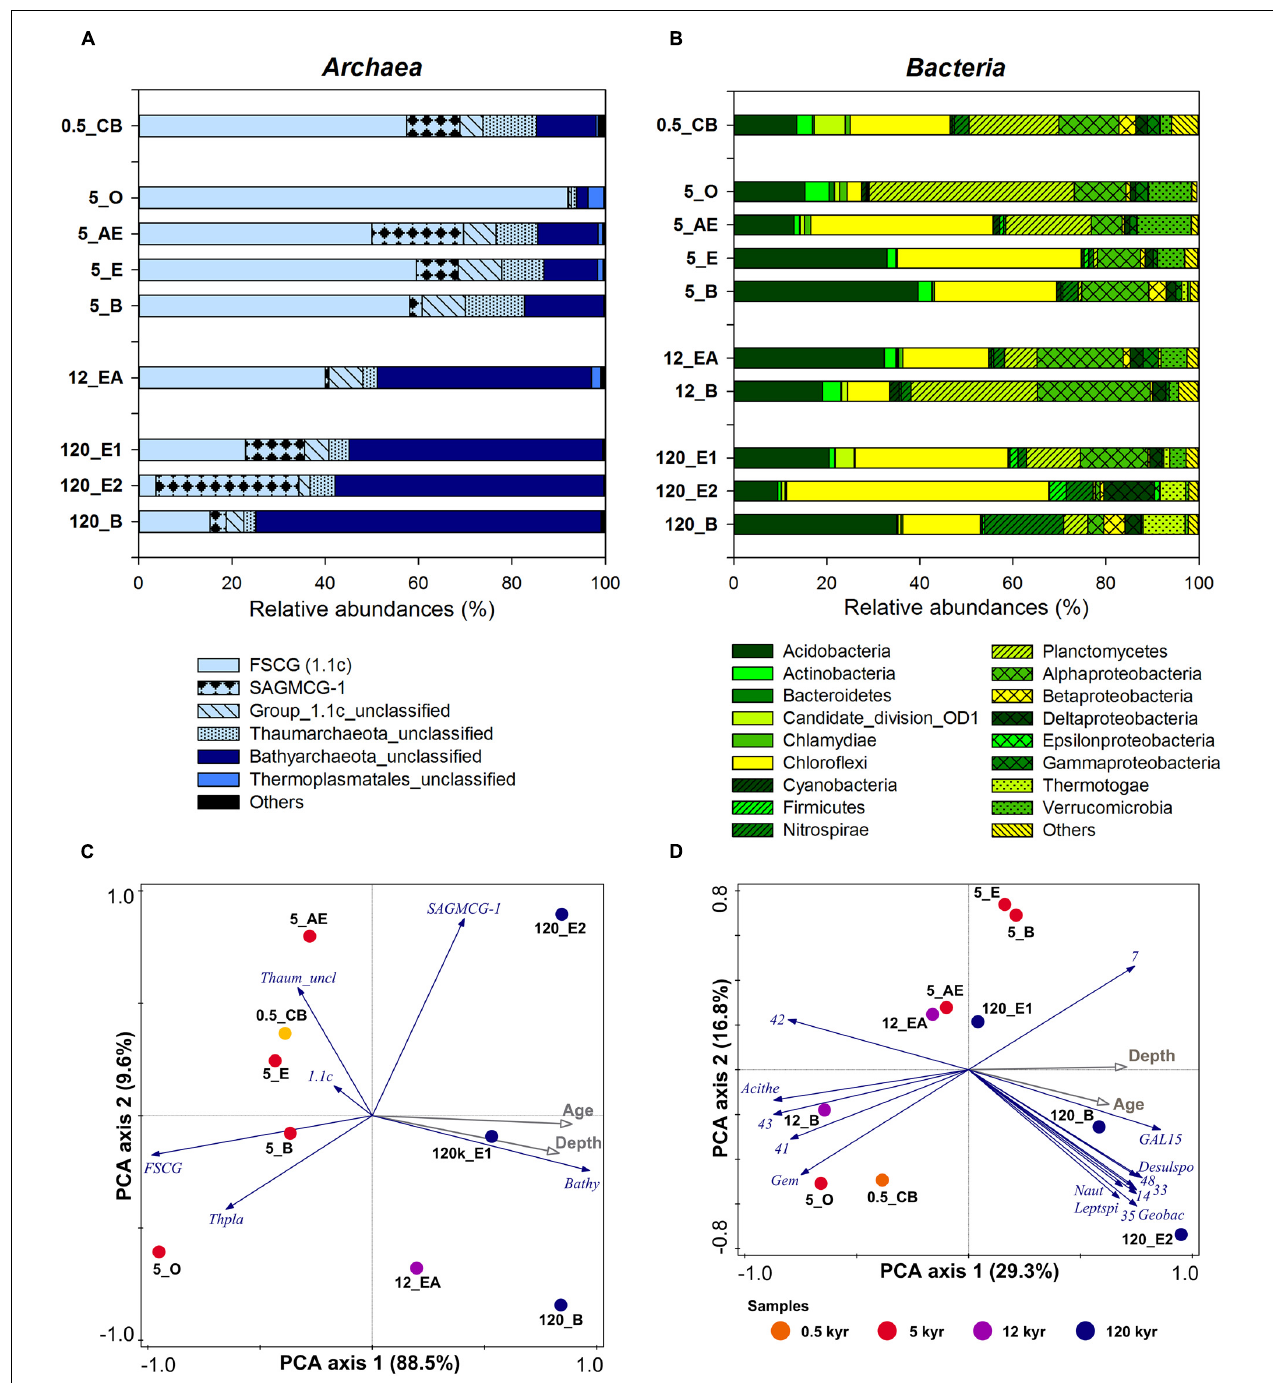
FIGURE 2 | Microbial community composition of selected original soil samples (0.5, 5, 12, and 120 kyr soil age) along the Franz Josef chronosequence based on pyrosequencing analysis. Relative abundances (%) of (A) archaeal groups, and (B) bacterial phyla and classes ( Proteobacteria ). (C) Principal component analysis (PCA) of archaeal community composition based on relative abundances of archaeal groups with soil age and soil depth as supplementary variables (gray arrows). 1.1c , Thaumarchaeota 1.1c ; Bathy , Bathyarchaeota ; FSCG , Forest Soil Crenarchaeotal Group; SAGMCG-1 , South African Gold Mine Crenarchaeotal Group 1 ; Thaum_uncl , unclassified Thaumarchaeota , and Thpla , Thermoplasmatales . (D) PCA of bacterial community composition based on log-transformed relative abundances of bacterial genera (15 best-fitting as blue arrows) with soil age and soil depth as supplementary variables (gray arrows). Acithe , Acidothermus ; Desulspo , Desulfosporosinus ; GAL15 , candidate division GAL15; Gem, Gemmata ; Geobac , Geobacter ; Leptspi , Leptospirillum ; Naut , Nautilia . Uncultured genera belong to 7, Acidobacteria ; 14, Chloroflexi ; 33, 35, Nitrospirae ; 41, Planctomycetes ; 42, 43, Alphaproteobacteria ; 48, Deltaproteobacteria . Symbol colors encode the different soil